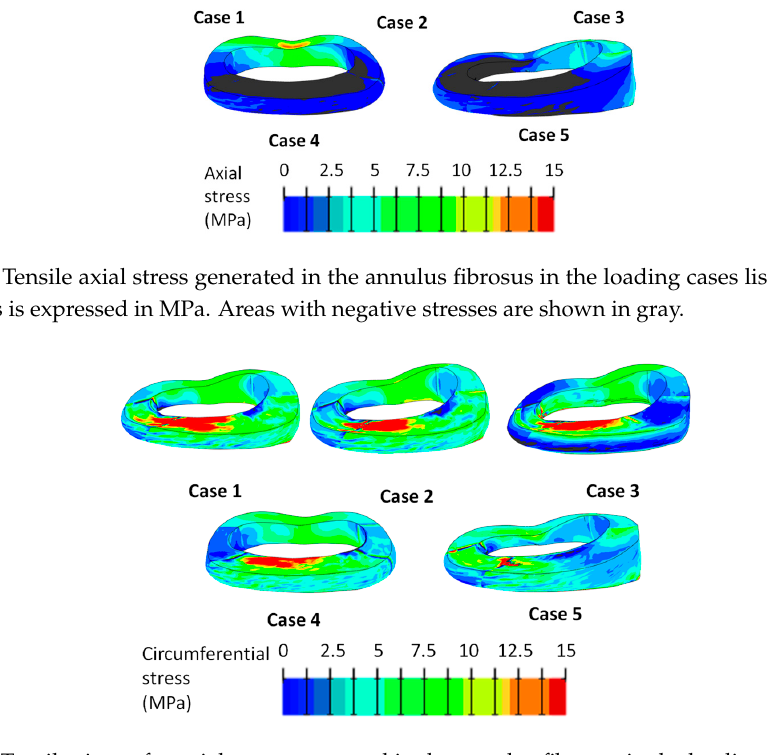
Figure 3. Tensile circumferential stress generated in the annulus fibrosus in the loading cases listed in Table 2. The stress is expressed in MPa. Areas with negative stresses are shown in gray.